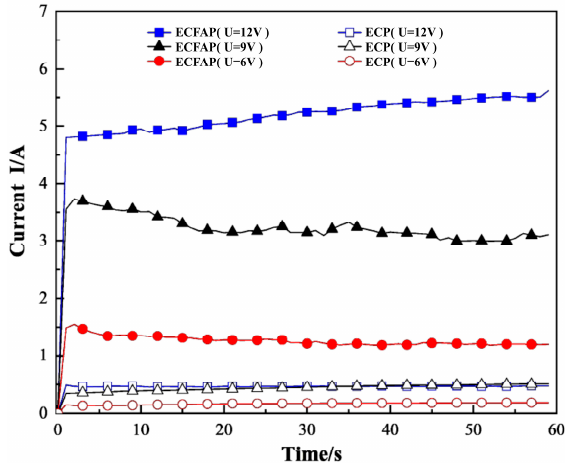
Figure 10. Comparison of current values measured during ECM and ECFAP treatments.